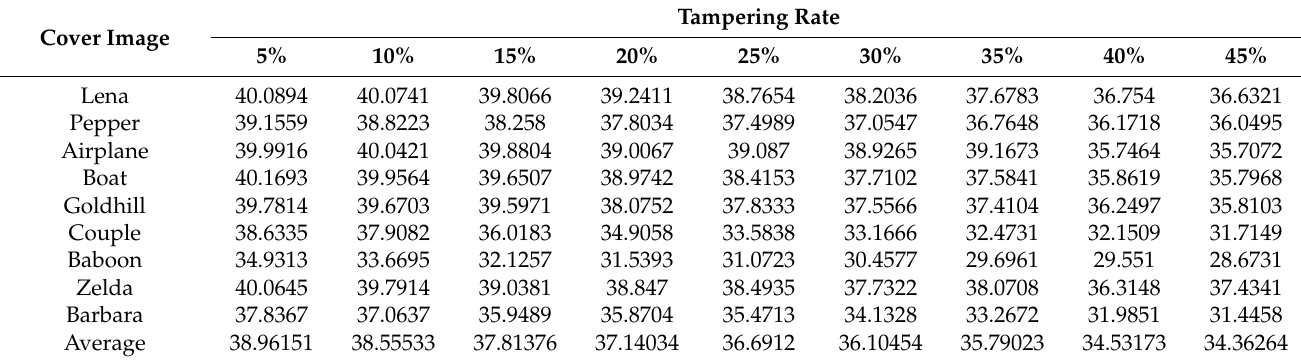
Table 2. SSIM comparisons between original images and recovered images according to tampered rates. Cover